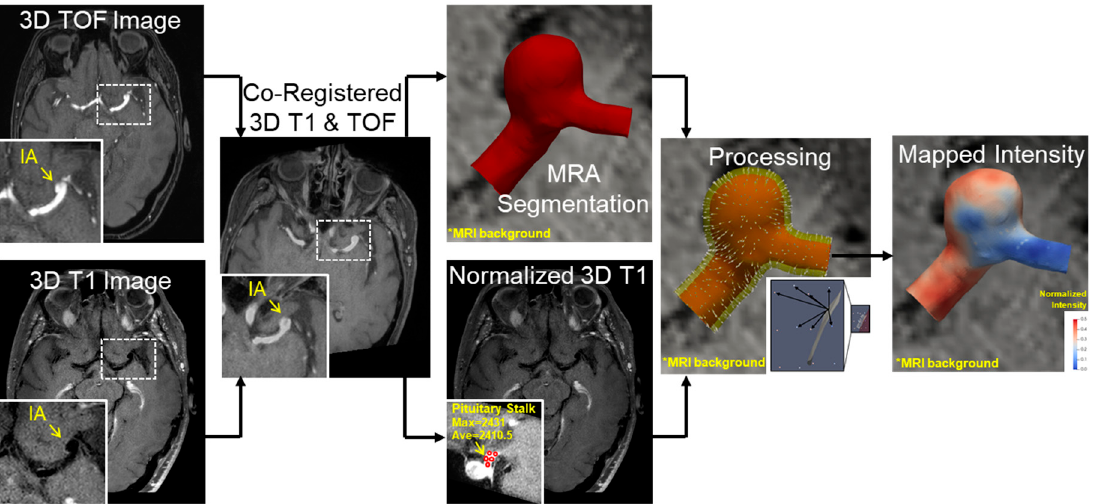
Figure 1. Pipeline for vessel wall enhancement quantification—Post-contrast MRI and MRA images are taken as inputs for this pipeline. The MR image is first normalized by the average contrast intensity at the pituitary stalk. The MR image is then registered on to the MRA image. The MRA image is segmented to generate a surface file. Following this, the region of interest is identified and then the voxels normal to each surface are interpolated on to the surface to generate the final contour as shown.